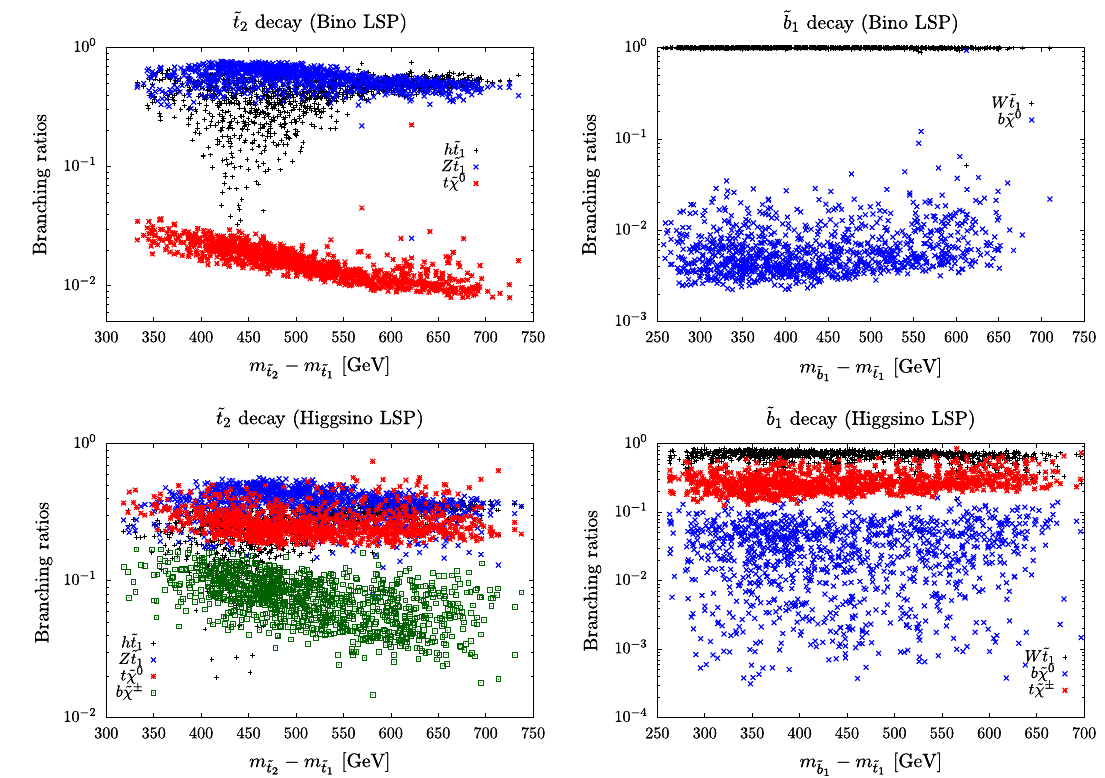
Fig. 1 ˜ t 2 ( left panels ) and ˜ b 1 ( right panels ) decay branching ratios for bino LSP ( upper panel ) and Higgsino LSP ( lower panels